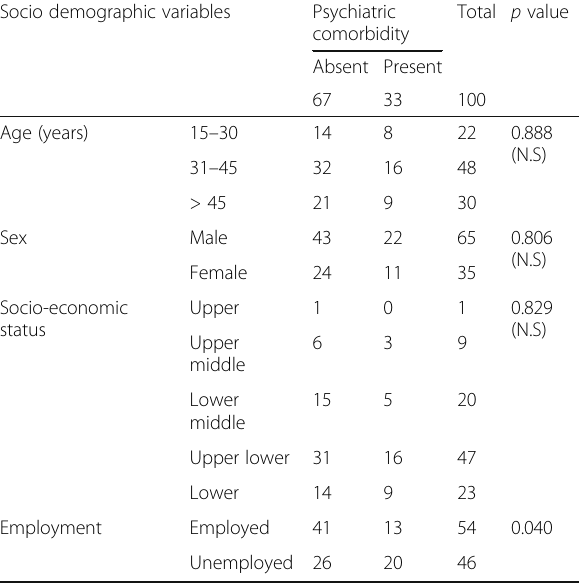
Table 1 Sociodemographic data and clinical characteristics of